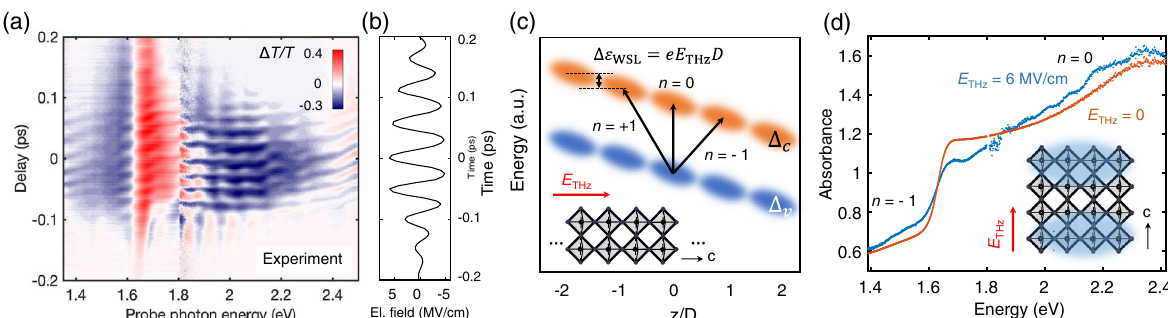
Fig. 2 Experimental observation of the transient Wannier – Stark localization and the visualized diagram. a Experimental differential transmission spectra on a polycrystalline fi lm of MAPbI 3 perovskite at room temperature, as a function of delay time of probe pulses after THz pump pulses. The THz pulses have a peak fi eld strength of 6 MV/cm and a center frequency of 20 THz; the probe pulses have photon energy of 1.4 ~ 2.4 eV. b Temporal pro fi le of the applied THz bias transient. c Schematic picture of Wannier – Stark localization. In the presence of strong external fi elds along the c axis, electronic states (orange: conduction band, blue: valence band) are localized to a few layers of ab plane and energetically separated by Δ ε WSL = eE THz D between adjacent lattice sites. Black arrows depict the interband transitions within the same site ( n = 0) and between different sites ( n = ±1). d The absorbance with and without the external transient biasing. The Wannier – Stark localization effectively reduces the 3D electronic structure into 2D layered structure along the ab plane, as depicted in blue together with the simpli fi ed 3D structure. In case of E THz = 6 MV/cm in considering the lattice constant D of 12.5 Å, Δ ε = eE D is estimated to be 750 meV, consistent with the spectrum showing that the absorption band of n = − 1 and n = 0 are ~750 meV WSL THz